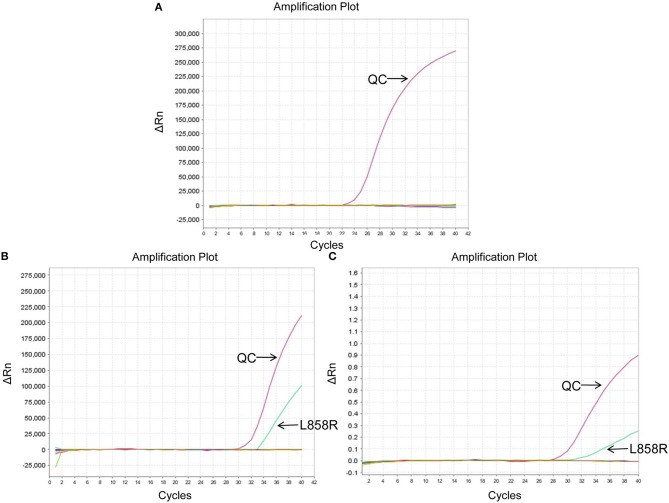
EGFR mutation status of patient No.23 using different sample types. (A) Wild type in tumor tissues. (B) Exon 21 L858R in cell blocks. (C) Exon 21 L858R in exosomes. ΔCt was defined as the difference between the Ct value of specific mutation type and QC. And it was considered positive for exon 21 L858R when ΔCt was <7. QC, quality control (a house-keeping gene).